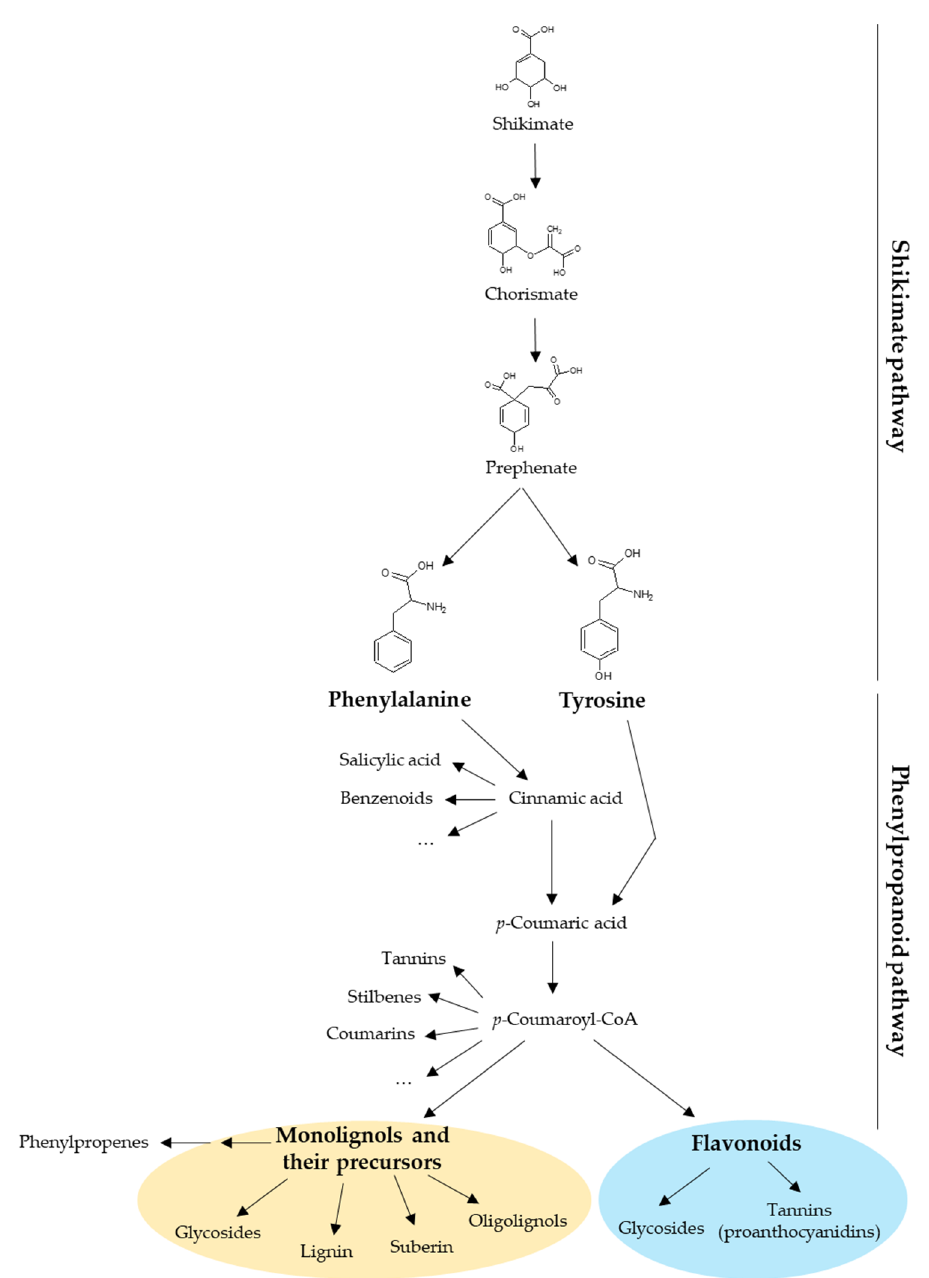
Figure 1. Diversity of compounds produced by the shikimate and the phenylpropanoid pathways in plants. The shikimate pathway yields phenylalanine and tyrosine, which are the precursors of phenylpropanoids. This review focuses on two phenylpropanoid families: the monolignols (yellow circle) and the flavonoids (blue circle). CoA, coenzyme A.